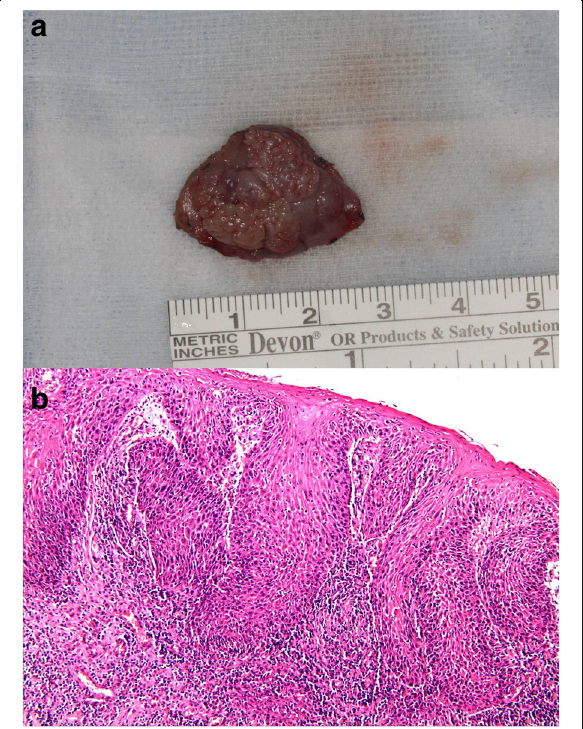
Fig. 2 a Gross anatomy. Macroscopically, the excised specimen had dimensions of 2.1 × 2.0 × 0.3 cm. b Microscopic examination